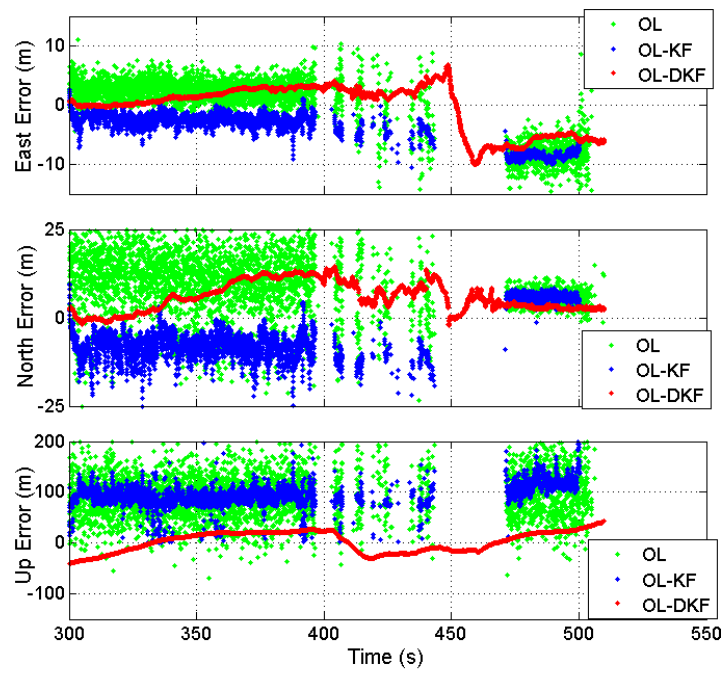
Figure 31. Three-dimensional errors of roads in the city canyon test.